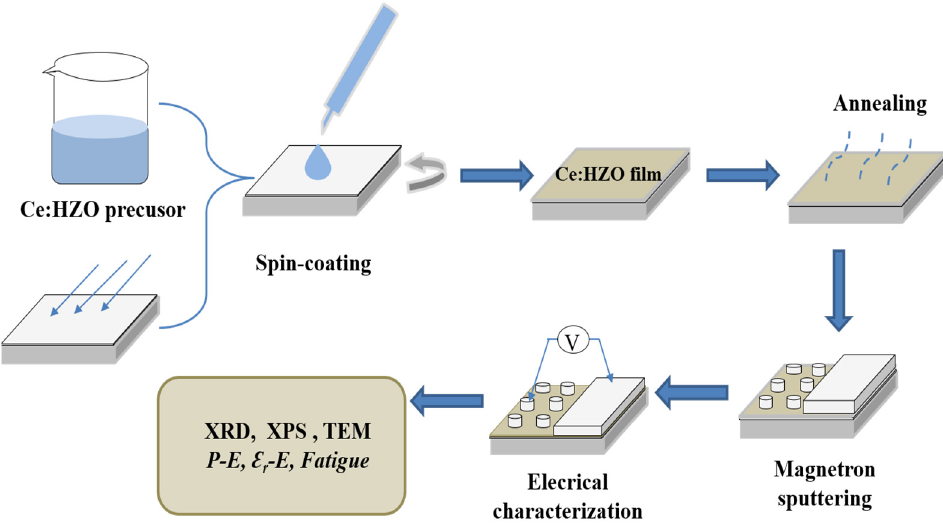
Figure 1. Schematic diagram of the experimental process.